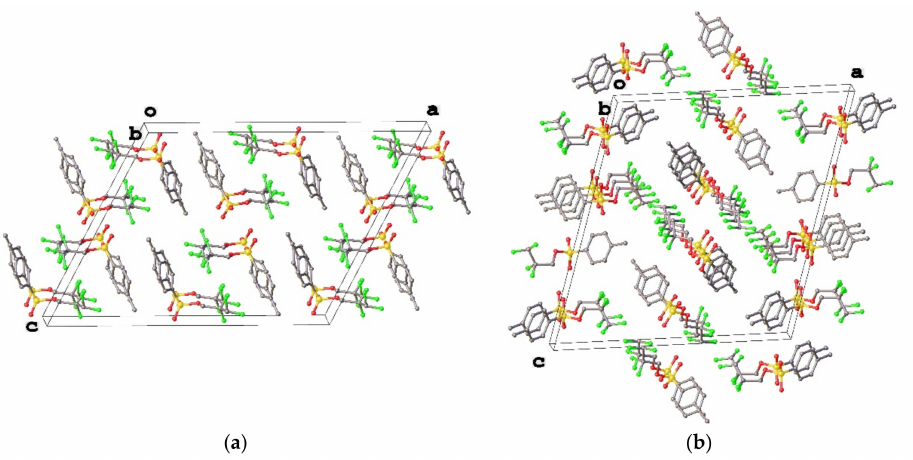
Figure 8. Crystal packing of polymorphs 2a ( a ) and 2b ( b ).